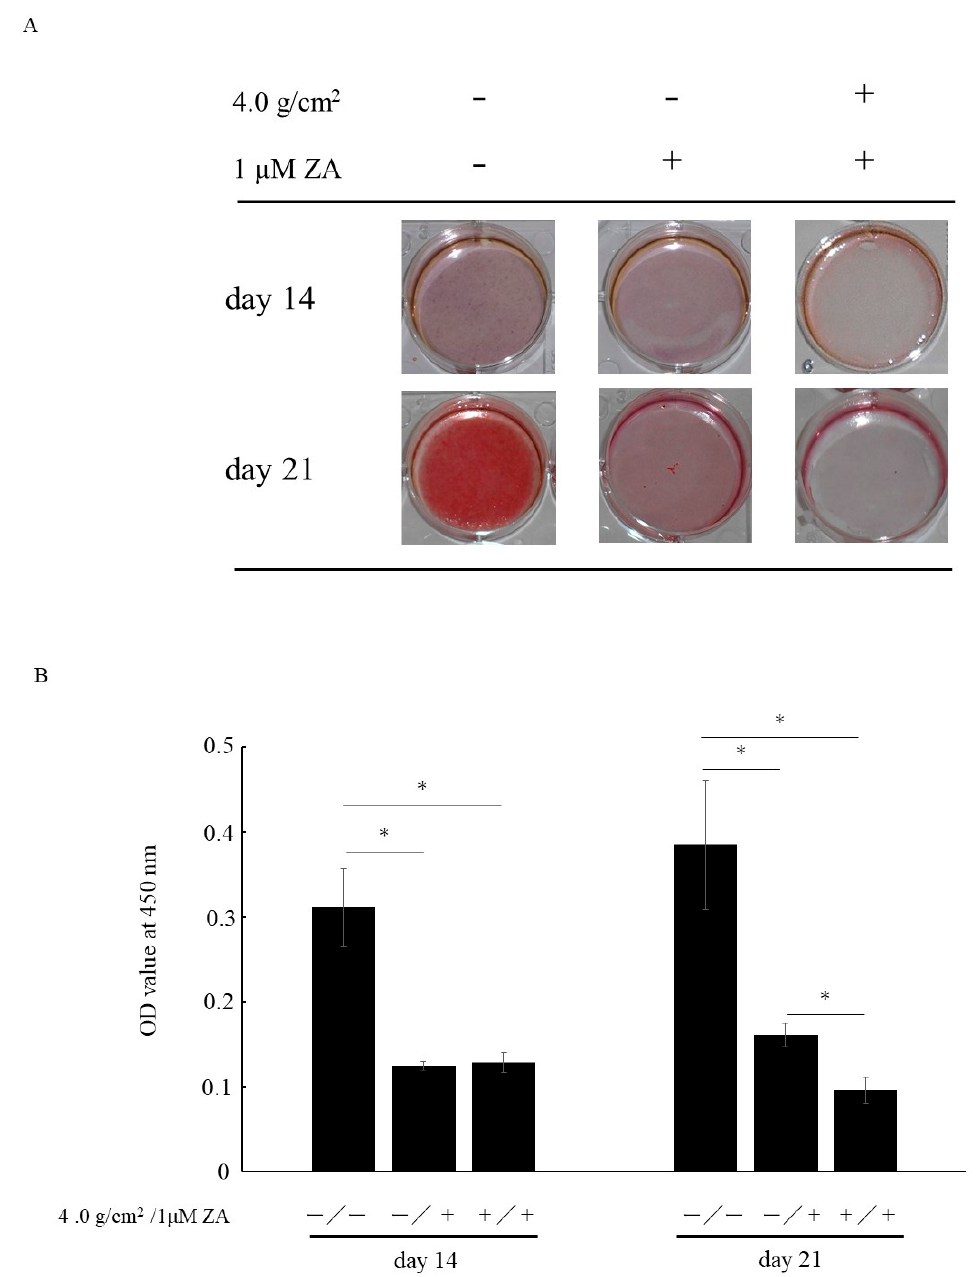
Figure 4. Matrix mineralization is assessed by Alizarin Red S (ARS) staining ( A ). After ARS staining, dye is extracted and quantified ( B ). Data represent mean ± SD. * p < 0.05.